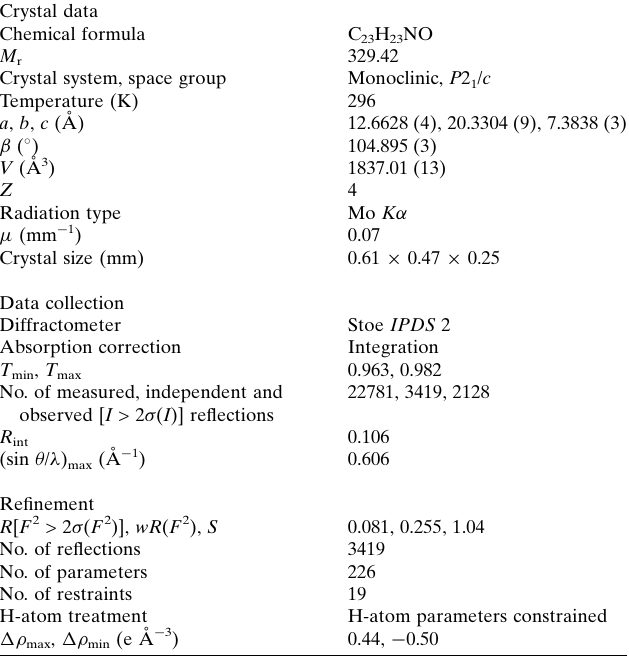
Table 2 Experimental